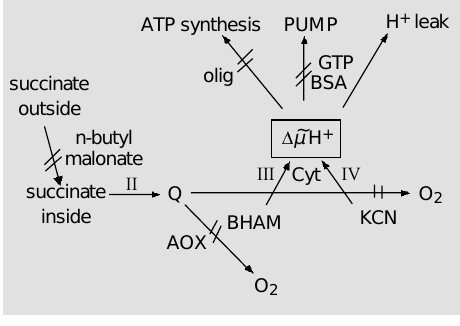
Figure 2 - Respiratory network in tomato mitochondria. Com-